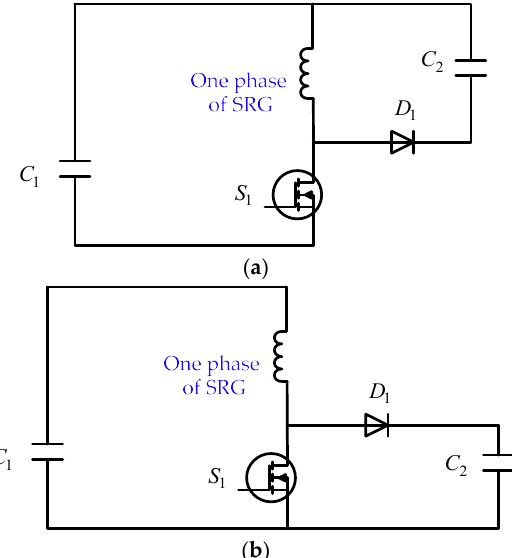
Figure 8. Buck and boost converters. ( a ) Topology of the boost converter. ( b ) Topology of the buck converter.